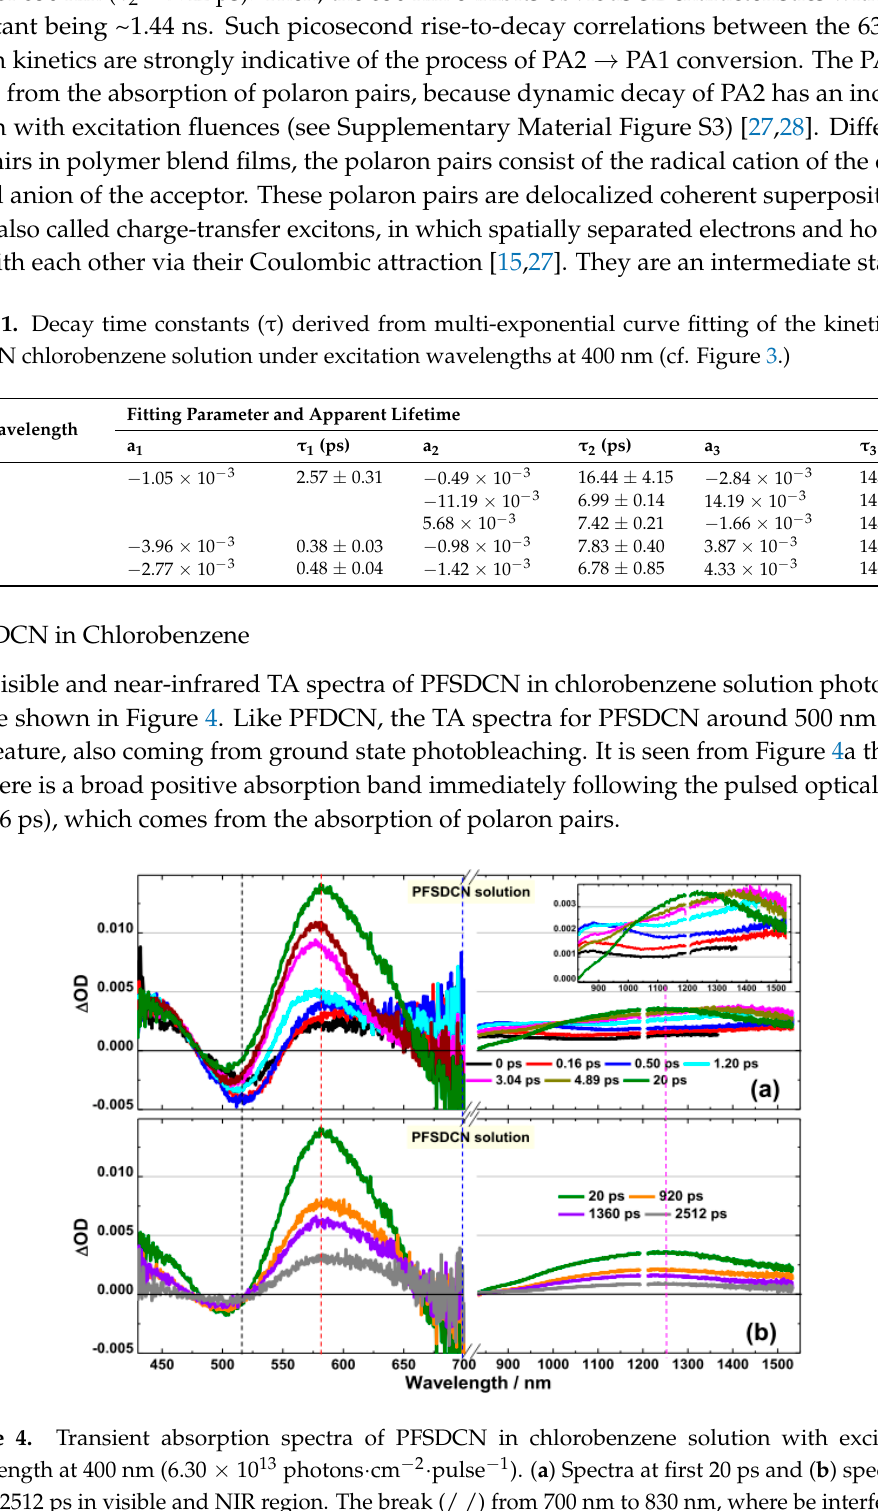
Table 1. Decay time constants ( τ ) derived from multi-exponential curve fitting of the kinetics for